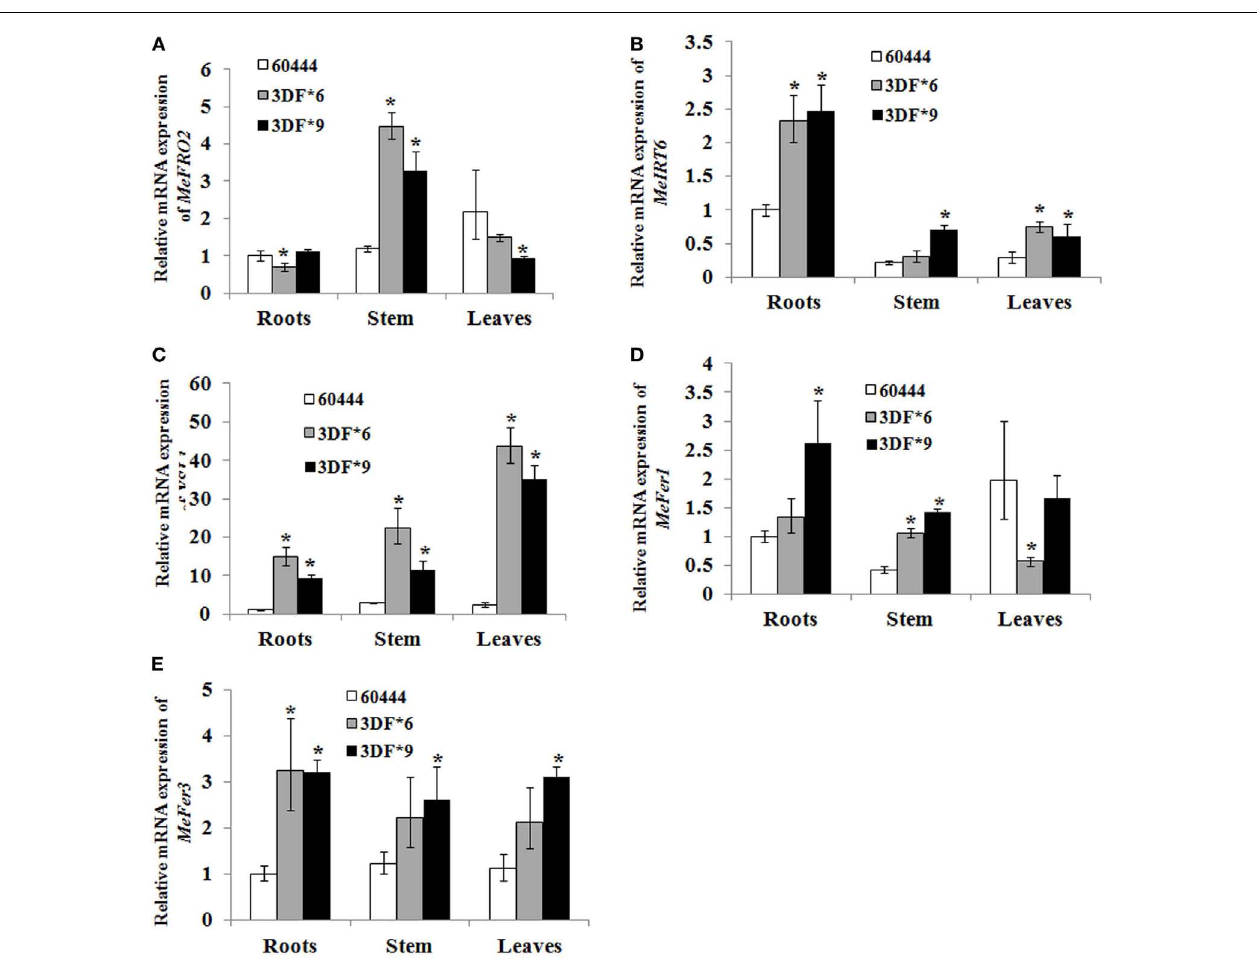
FIGURE 9 | Differential expression of metal regulated genes in FEA1 transgenic cassava. Relative expression (Q-RT-PCR) of metal regulated genes [ (A) ; MeFro2, (B) ; MeIrt6, (C) ; MeYsl1, (D) ; MeFer1, (E) ; MeFer3] as indicated in wild-type and two independent FEA1 transgenic lines.Tissues (roots, stem, and leaves) were collected at 1.5-month-old in vitro stage plants. Expression of the metal regulated genes was normalized to